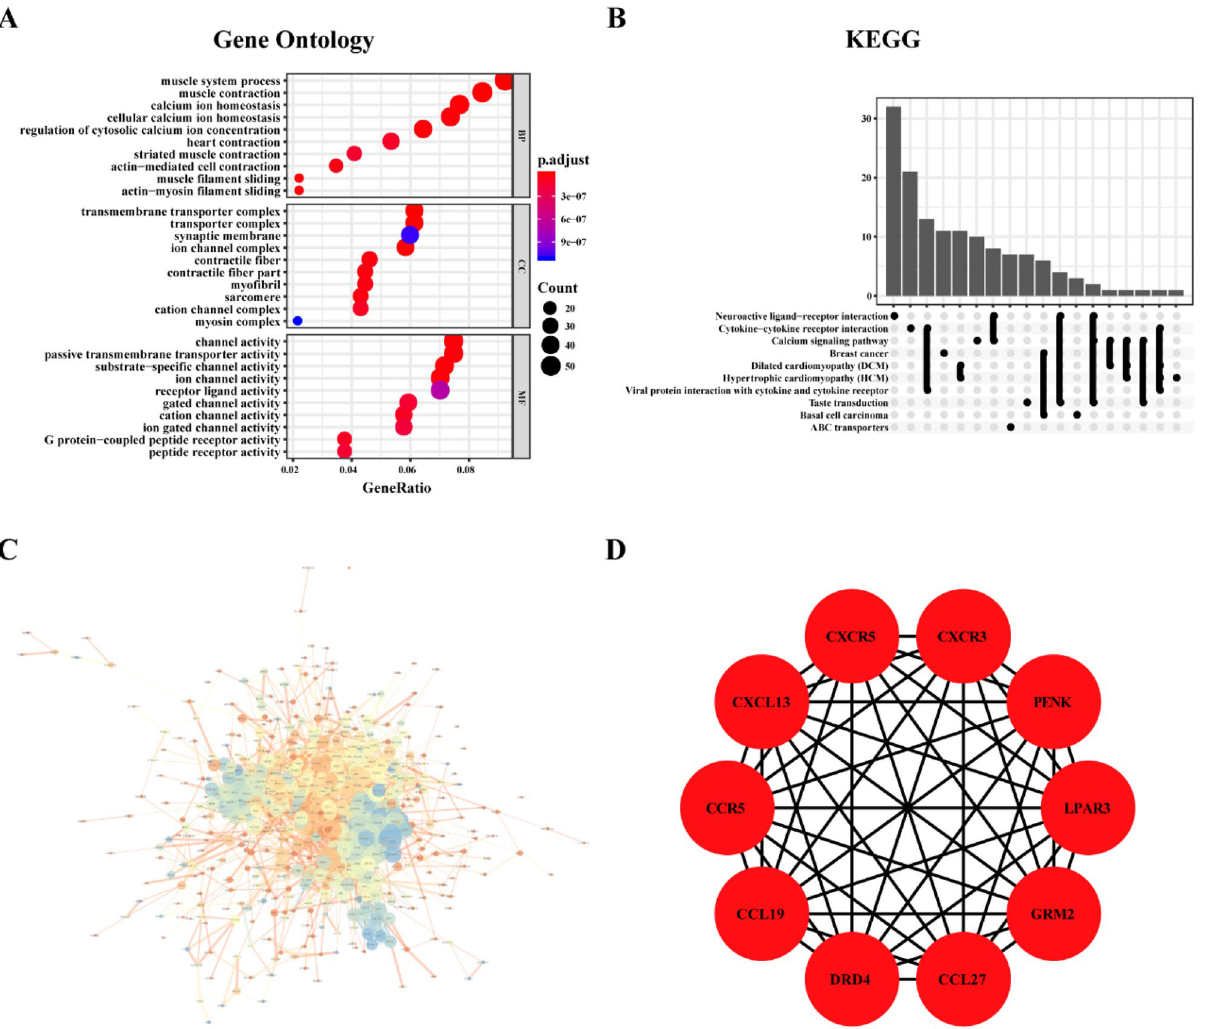
Figure 3. GO, KEGG, and PPI network analyses of DEGs. ( A ) GO biological function enrichment analysis. ( B ) KEGG pathway enrichment analysis. ( C ) PPI network analysis graph. The node size indicates the clustering coefficient; a larger node indicated a larger clustering coefficient, with a greater proportion of genes in the network. The node color indicates the degree; a higher degree indicated greater connectedness of the node. Blue represents a larger degree, yellow indicated a medium degree, and orange indicates a minimum degree. The thickness of the line represents the overall score. A higher score resulted in a thicker line, indicating a strong interaction between the two proteins. ( D ) Schematic representation of hub